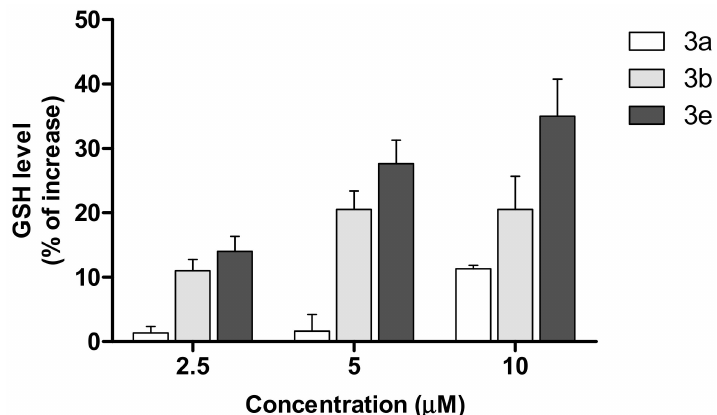
Figure 6. E ff ects of compounds 3a , 3b and 3e on GSH levels in SH-SY5Y cells. Cells were incubated for 24 h with di ff erent concentrations of the compounds (2.5–10 µ M). At the end of incubation, the GSH levels were measured using MCB assay. Data are expressed as a percentage of increase.